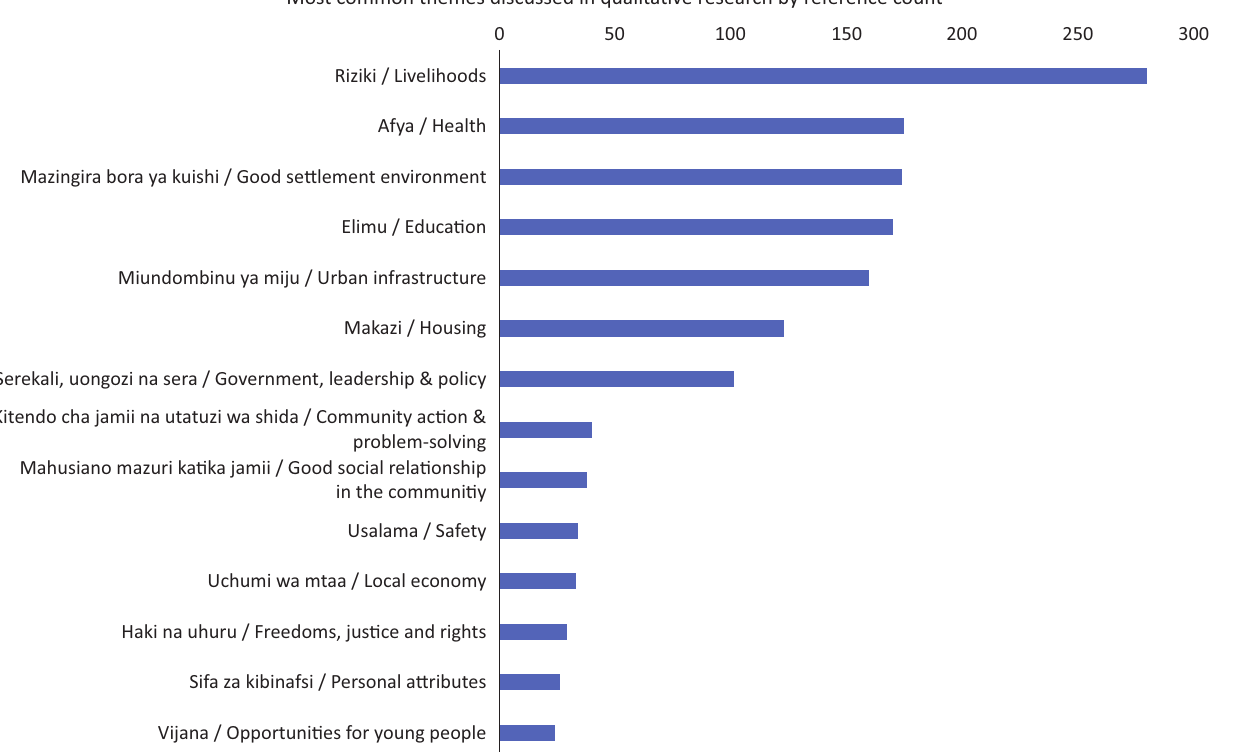
Figure 7. Most common themes in qualitative research in three informal settlements in Dar es Salaam (July–October 2019). Based on the unpublished CCI and IGP KNOW Project output of